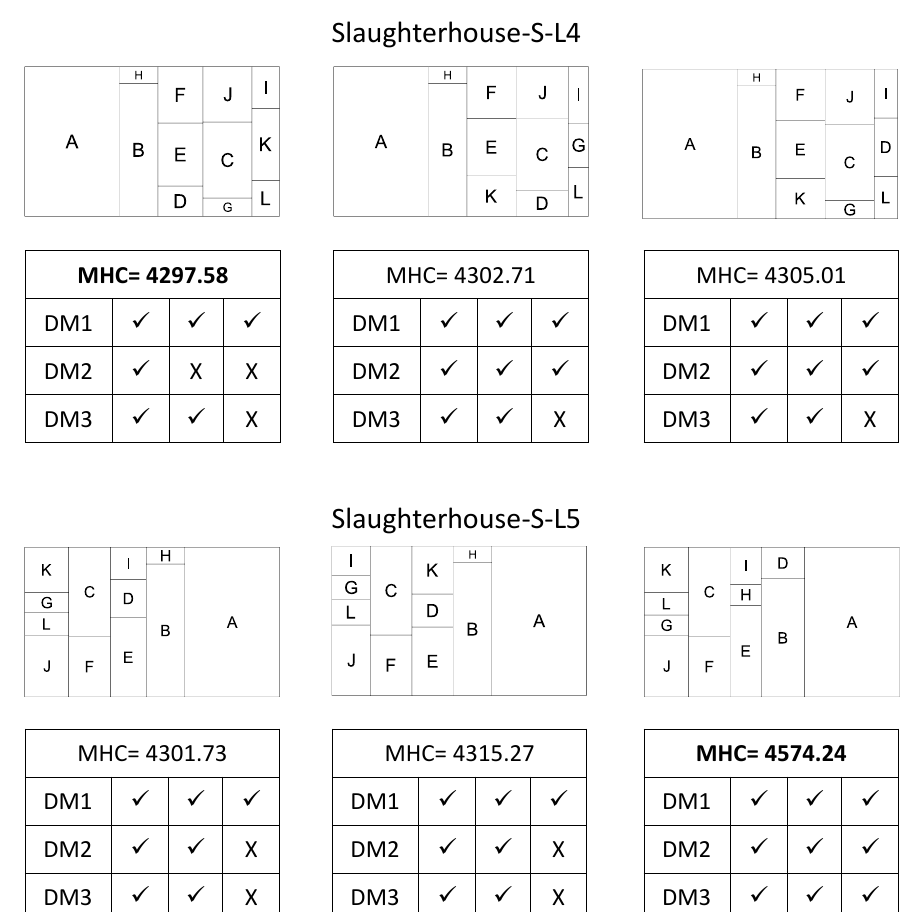
Figure 10. Best solutions found in Sequential launch 4 to 5 of Slaughterhouse